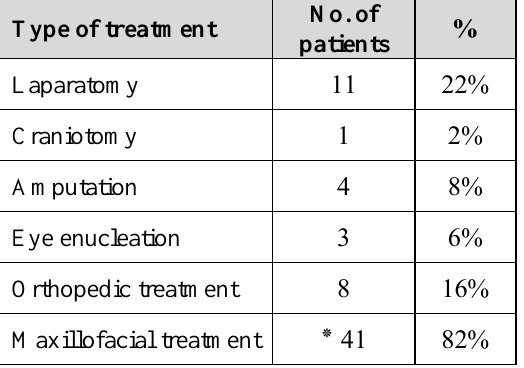
Table 2: Initial surgical teamwork treatments